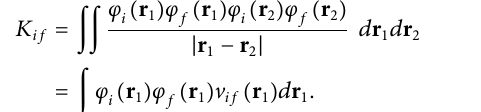
organic chromophores. PR ≡ present result. Details are available in Roy et al. (2021).